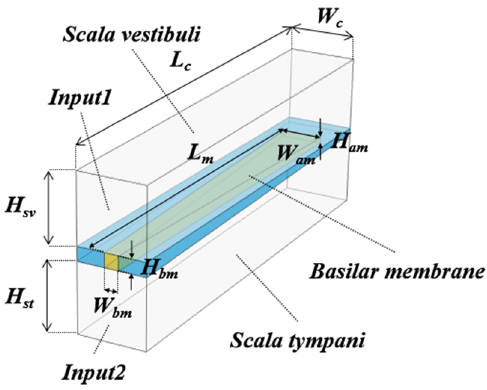
Figure 6. A cochlea–based symmetric model for even and odd mode analyses. Two input planes “input 1” and “input 2” are excited by in–phase (even mode) and anti–phase (odd mode) sound waves. The helicotrema is removed from the original model. Other structural parameters are completely the same as those of the cochlea model in Figure 1.